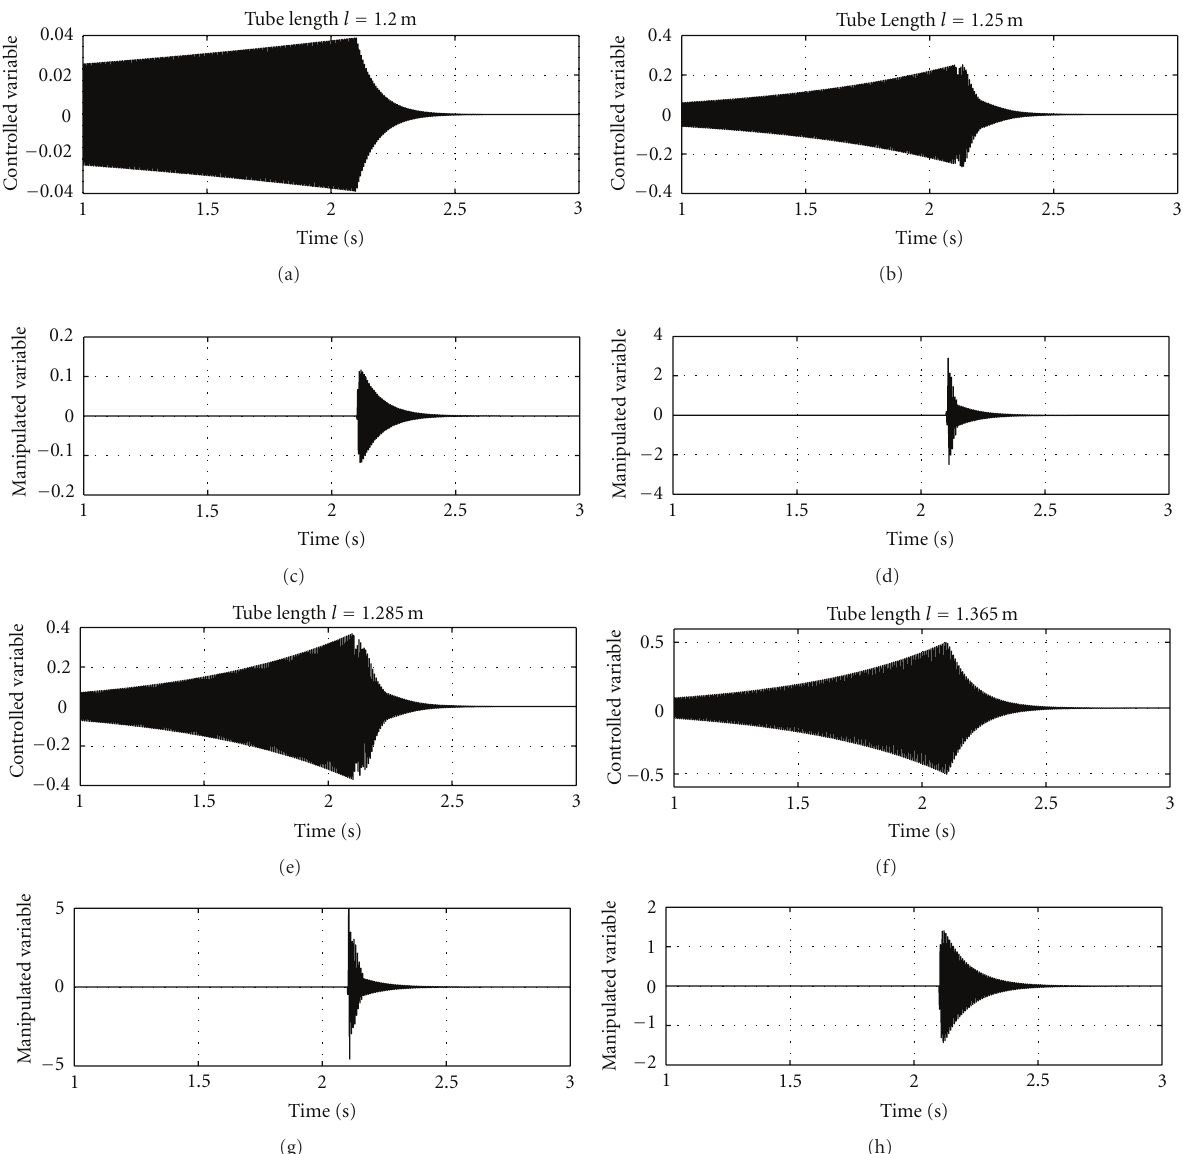
Figure 5: RMPC of the unstable Rijke tube with di ff erent length in simulation. The RMPC has a prediction horizon of N = 4 and uses a robust state observer. The RMPC is activated at t = 2 .